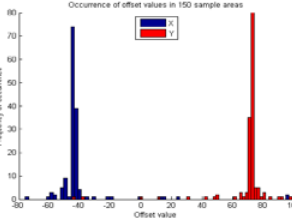
Figure 7. Histogram of X and Y offsets at 150